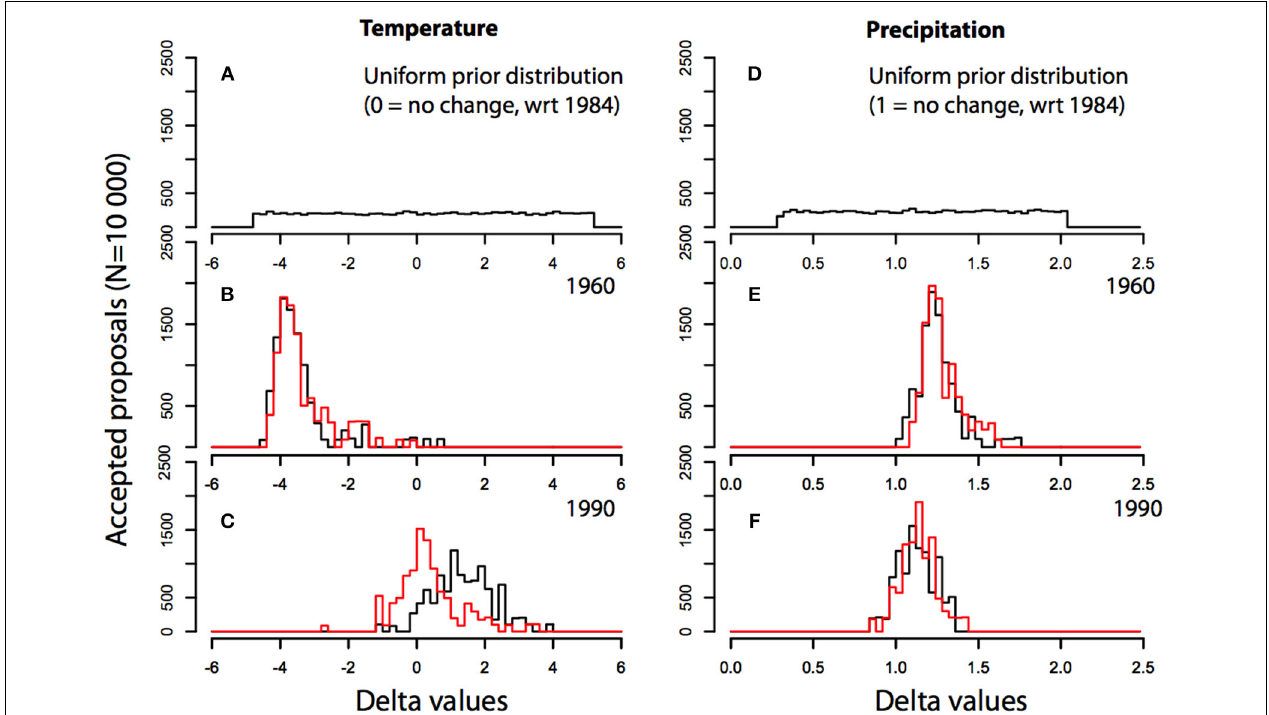
FIGURE 4 | Prior and posterior distributions ( N = 10 000 accepted proposals) of delta values for temperature (left) and precipitation (right). Deltas are additive (temperature) or multiplicative (precipitation) constants that are applied to the reference year (here 1984) to produce alternative meteorological scenarios that are iteratively injected in MAIDENiso, through the inversion algorithm. Prior distributions for temperature and precipitation